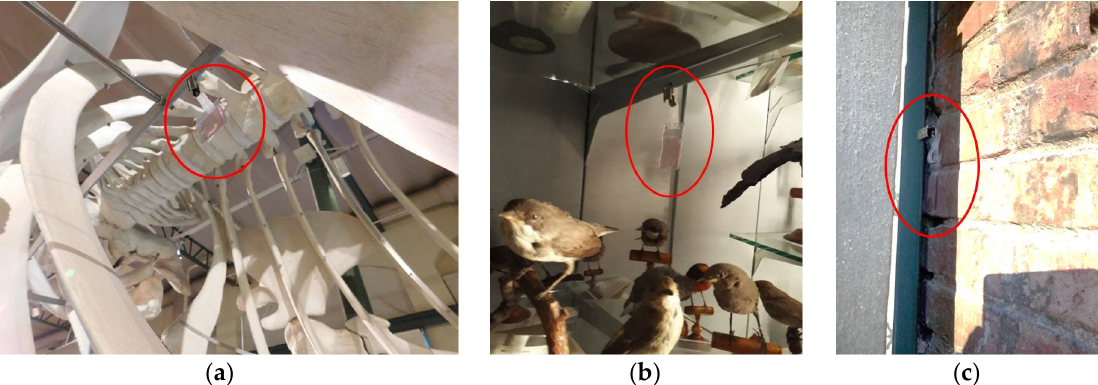
Figure 3. Some sensor positions. ( a ) Under the hall free environment. ( b ) Inside a showcase. ( c ) Outdoor in the main MNCN façade.